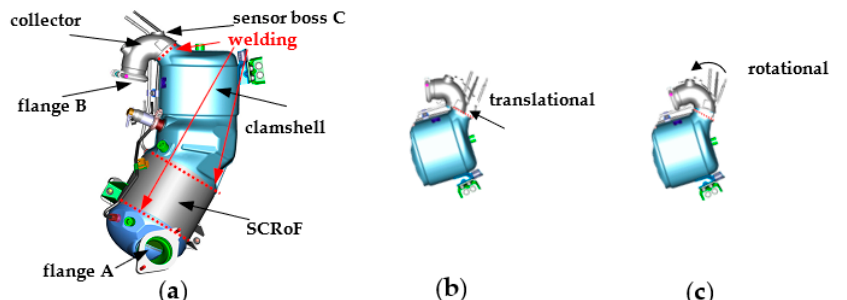
Figure 1. The catalytic converter: ( a ) the model; ( b ) possible translational; and ( c ) the rotational shift of the collector (courtesy of Marelli Europe SPA Green Technology Systems, Caivano, Italy).